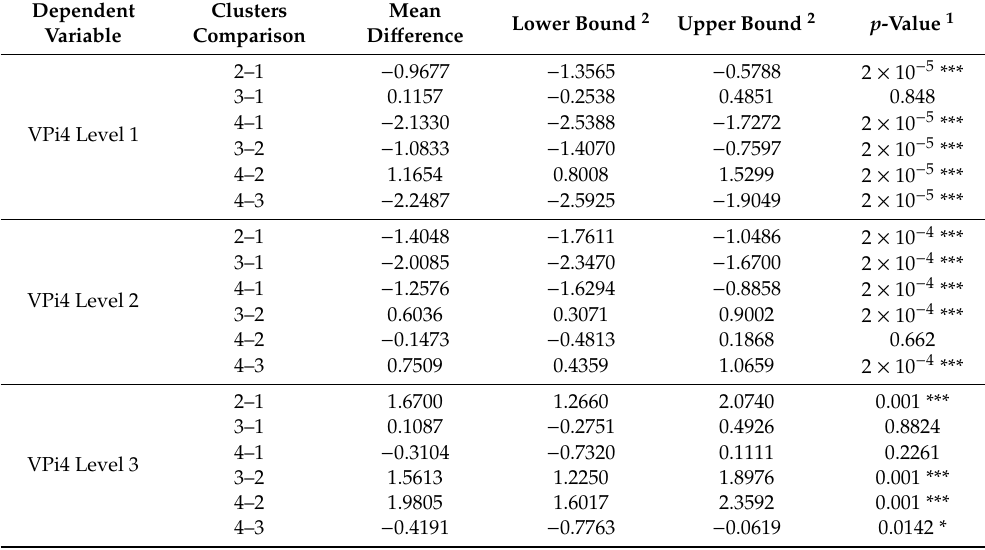
Table 6. Results of the Tukey Honest Significant Di ff erence (HSD)